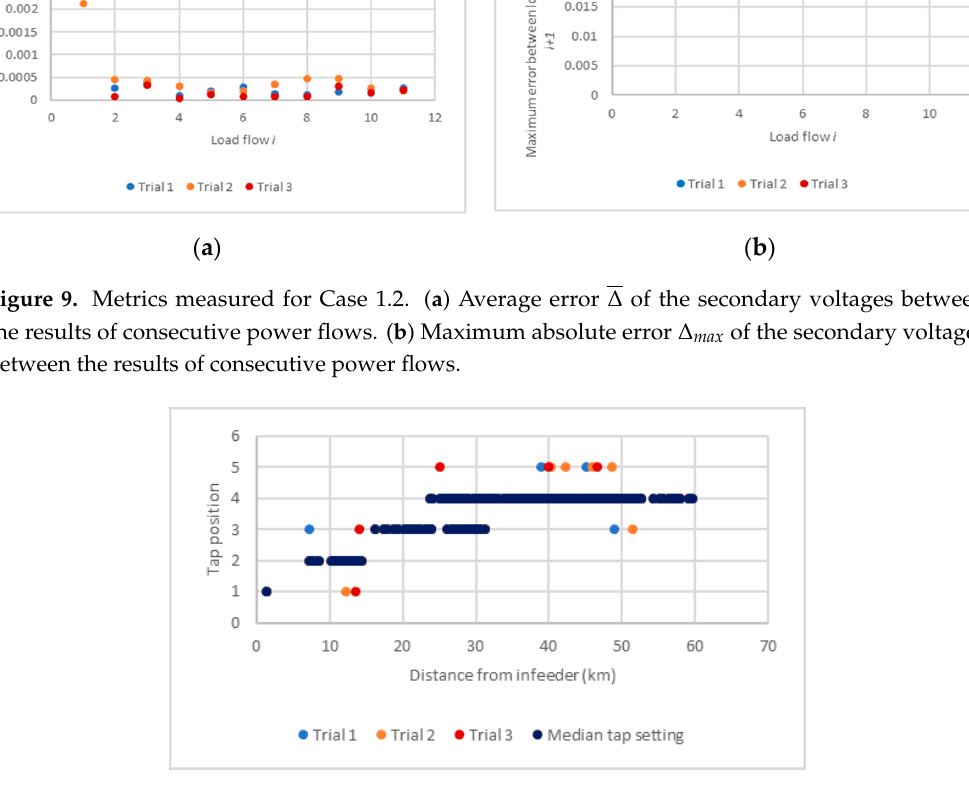
Figure 10. Transformer tap setting against electrical distance from the infeeder for Case 1.2. The median set of taps produced the lowest objective function and is therefore deemed the optimal set.